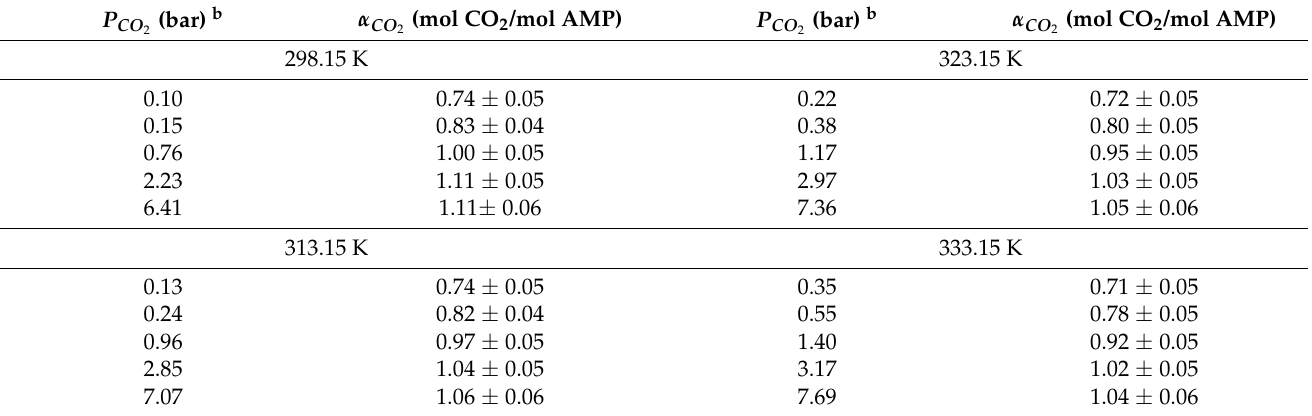
Table 6. CO 2 solubility in 17.7% wt. (2 M) AMP aqueous solutions at 298–333 K a .